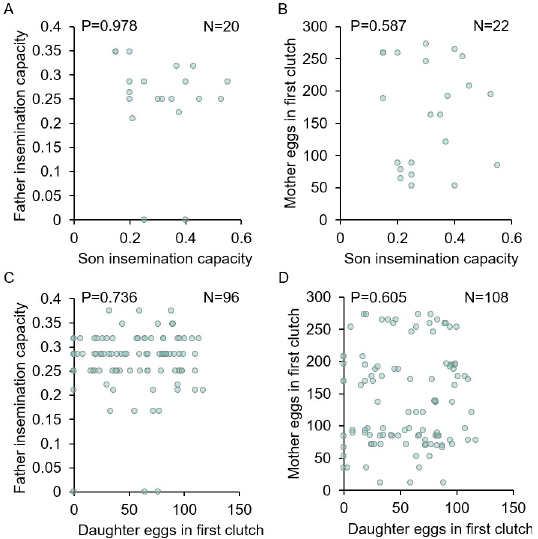
Fig 5. Parent reproductive fitness traits display low heritability and do not correlate with offspring traits. Father fertility and mother fecundity did not correlate with either son fertility (A and B) or daughter fecundity (C and D; P � 587 for all comparisons). Graphs display correlation sample sizes (N) and LMM P-values for each comparison. For detailed statistics, see S1